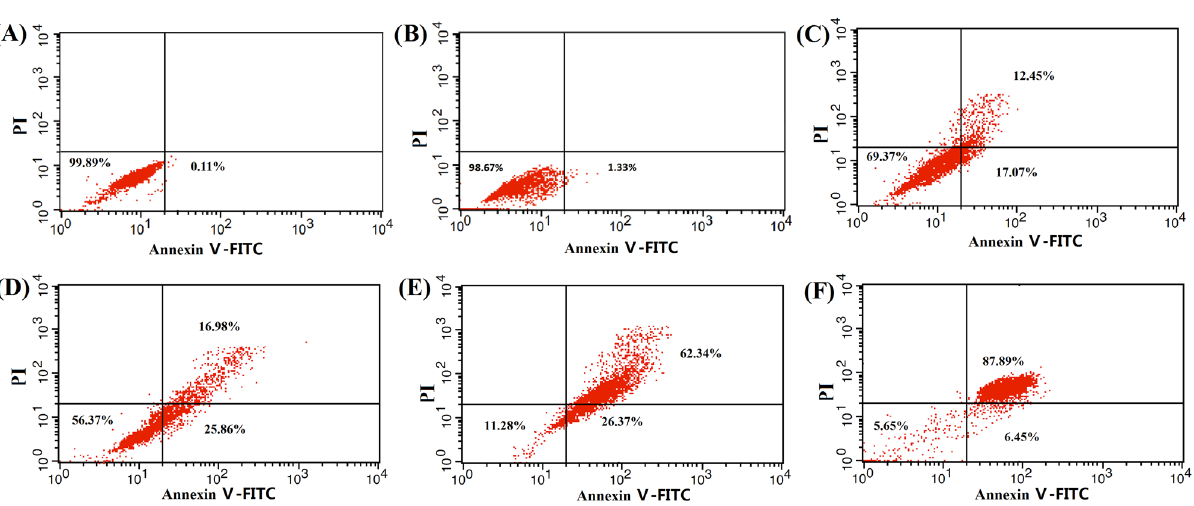
Figure 8. Synergistic effect of micelle-encapsulated Pluronic L61 unimers and curcumin on apoptosis of MCF-7/ADR cells treated with saline ( A ), F-pHSM ( B ), F-pHSM/DOX ( C ), F-pHSM/CUR/DOX ( D ), F-pHSM-L61/DOX ( E ) and F-pHSM-L61/CUR/DOX ( F